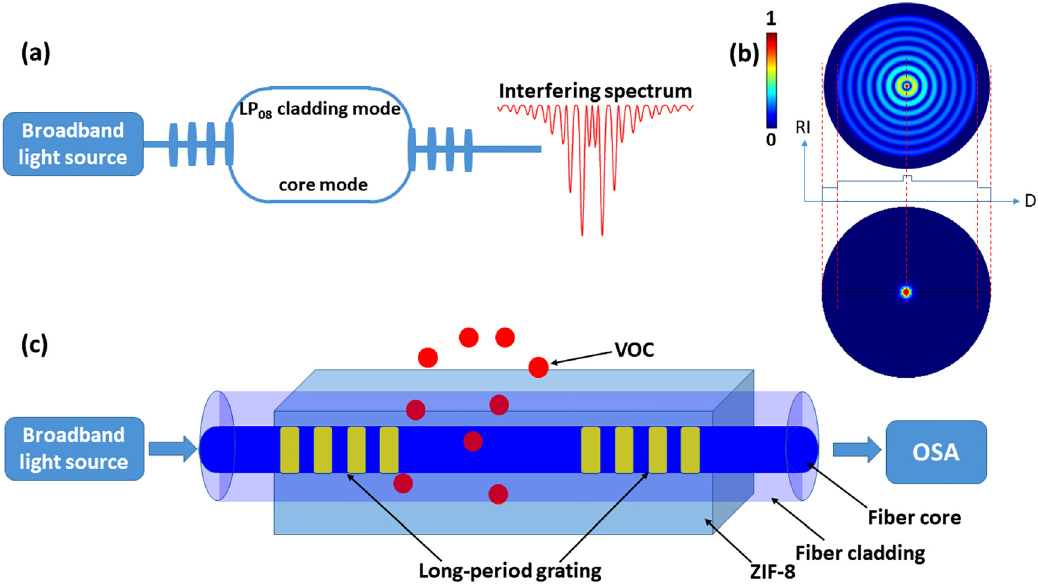
Figure2: (a)SchematicillustrationofMach – Zehnderinterferometer(MZI)withcascadedlong-periodfibergrating;(b)normalizedoptical fi eld distribution of LP 08 cladding mode and core mode and RI gradient from air, nanosurface to fi ber cladding and core; (c) illustration of optical fi ber MZI setup for VOC detection. RI, refractive index; D, diameter; VOC, volatile organic compound; OSA, optical spectrometer analyzer.